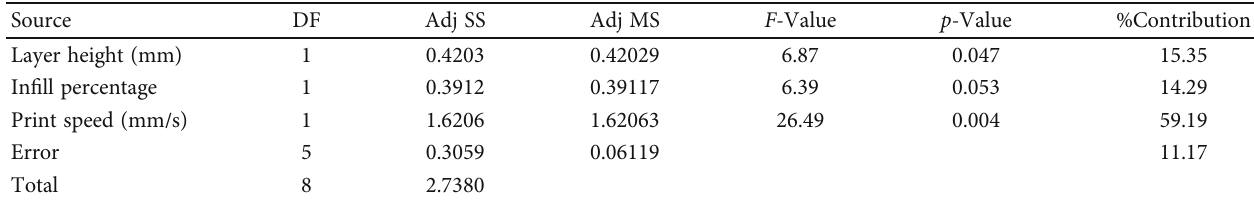
Table 5: Analysis of variance for impact